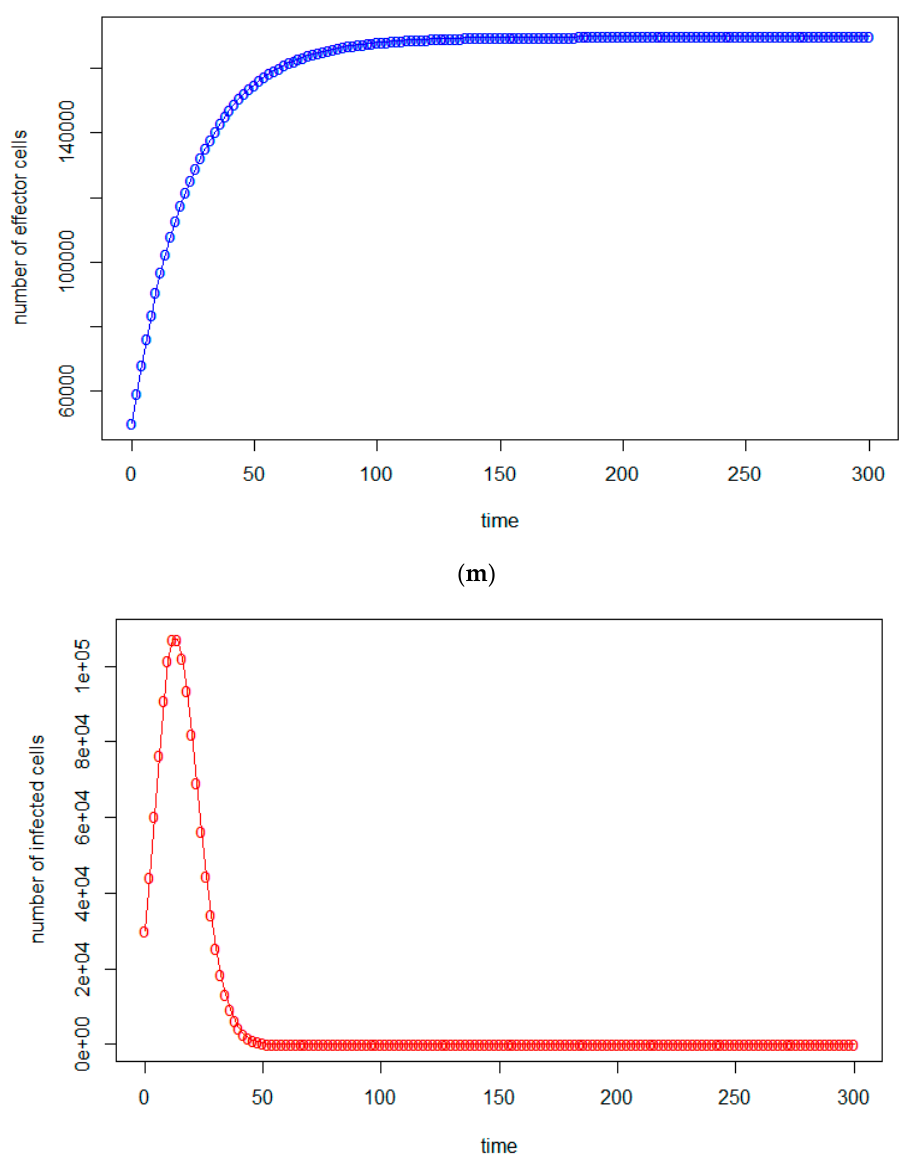
Figure 1. ( a , b ): The immune-effector cells ( a ) and virus-infected cells ( b ) vs. time (days), (note: ( a ) is on the left; ( b ) is on the right); ( c , d ): The relationship between the immune-effector cells and virus-infected cells.; ( e , f ): 3-D relationships of the effector cells, immune-effector cells and unit of time (days); ( g , h ): The immune-effector cells ( g ) and virus-infected cells ( h ) vs. time (days). The same as Case 1, except I 0 = 75,000 cellsvs. time (days); ( i , j ): The immune-effector cells ( i ) and virus-infected cells ( j ) vs. time (days). The same as Case 1, except V 0 = 15,000 cells; ( k , l ): The immune-effector cells ( k ) and virus-infected cells ( l ) vs. time (days). The same as Case 1, except V 0 = 15,000 cells and I 0 = 75,000 cells; ( m ): The immune-effector cells vs. time (days); ( n ): The virus-infected cells vs. time (days).